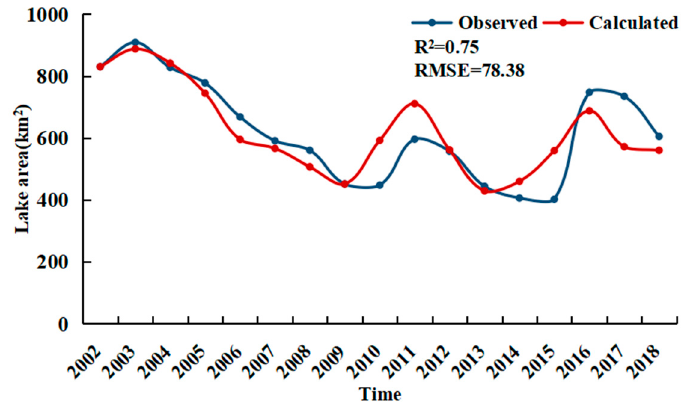
Figure 10. Prediction of lake area based on inflow.